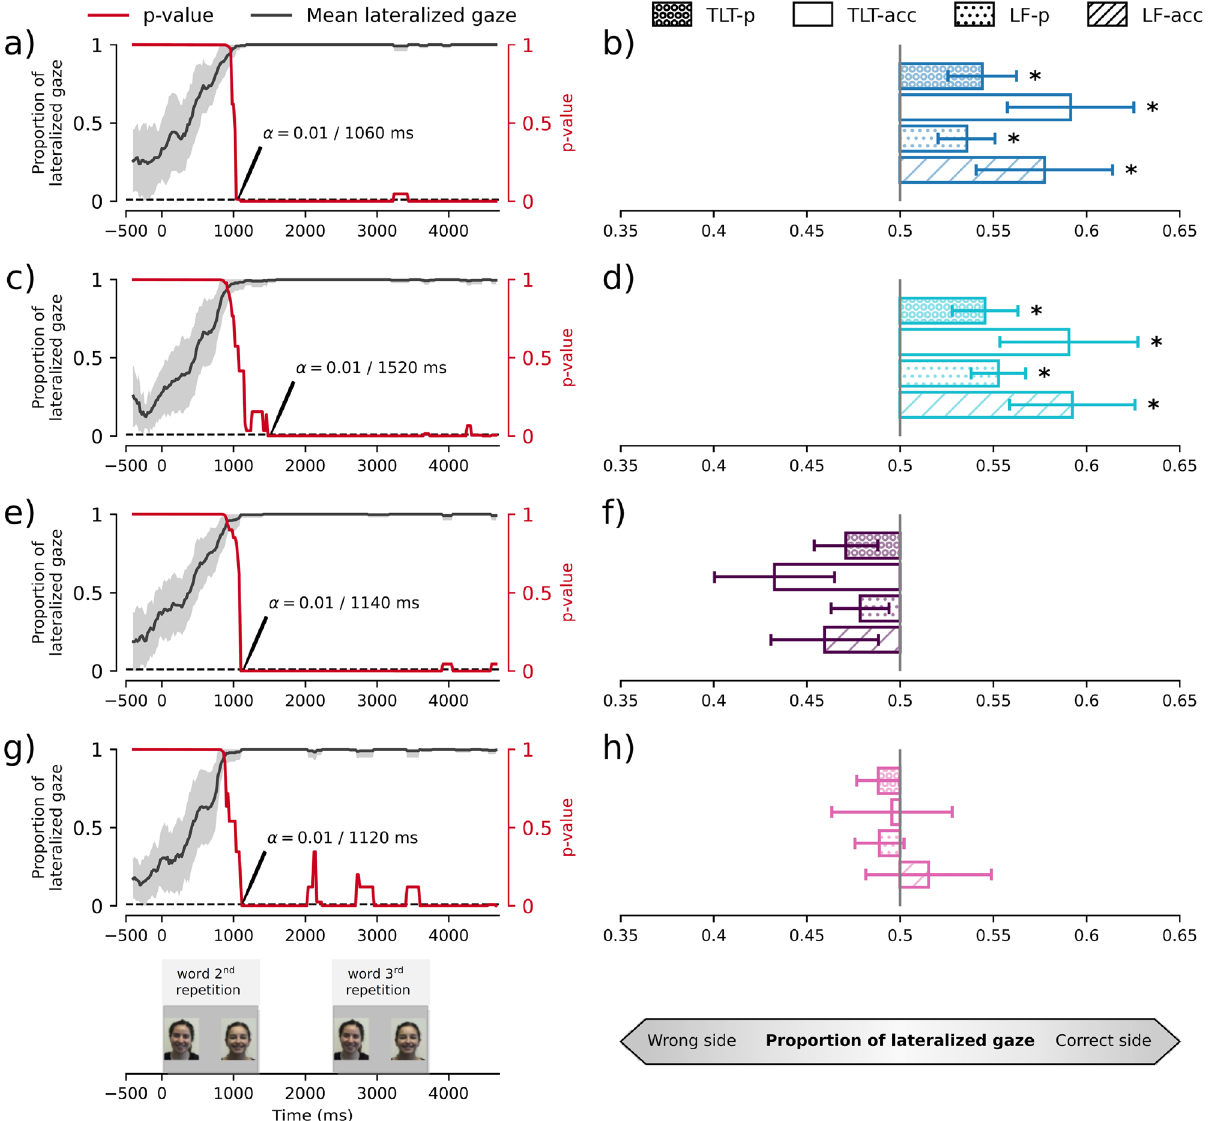
Figure 2. Window time for the analysis in each experiment. Left panels illustrate the time window when the mean gaze computed across all infants remained lateralized in ( a ) for Experiment 1, ( c ) for Experiment 2, ( e ) for Experiment 3, and ( g ) for Experiment 4. The black lines plot the proportion of lateralized gazes computed across all infants, from 500 ms before the presentation of the lateralized images to the end of the trial. The shadow indicates the standard deviation. The trial events inside the analysis window appear below the left panels. The y-axis encompasses from 0, when the gaze fell into the center of the screen, to 1 when was lateralized regardless of the side and correctness. The red lines depict the P value at each point of the same time window and show the period when the infants’ gaze shifted from the center to the lateralized images and remained there (see Methods). The horizontal dotted line indicates P value < 0.01. The gray arrows indicate the onset of the time window we used for the analysis, which extended to 4700 ms in all experiments. The right panels show the accuracy for Experiment 1 in ( b ), Experiment 2 in ( d ), Experiment 3 in ( f ), and Experiment 4 in ( h ), illustrated as the mean TLT-p, TLT-acc, LF-p, and LF-acc. In the x-axis, 0.5 indicates no preference or mean gaze at chance level, values greater than 0.5 indicate a visual preference towards the correct image, while those below 0.5 a preference towards the incorrect image. The asterisks indicate a significant difference from the chance at P <